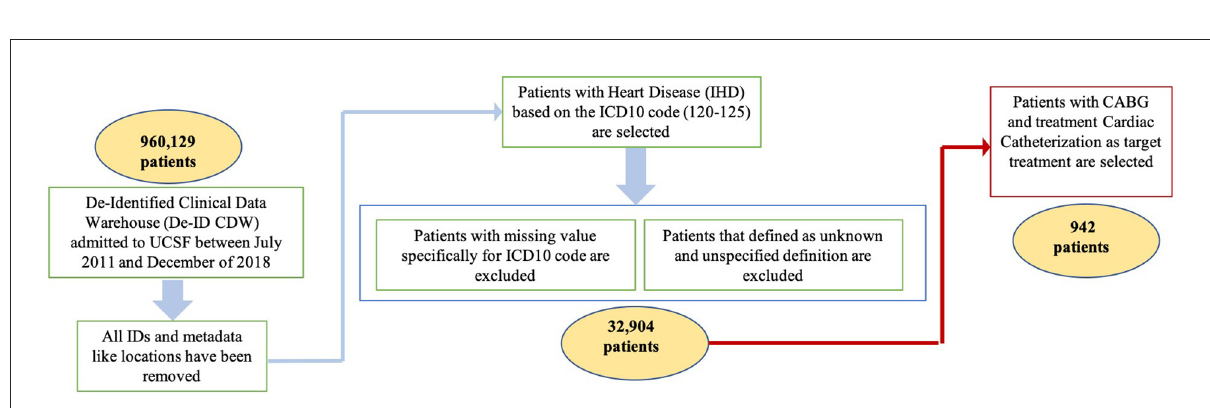
Ischemic Heart Disease (IHD) based on the ICD10 code (120-125). All patients have an initial event at the time of enrollment at UCSF (medication and/or noninvasive procedure). A number of 46,996 patients are selected in this